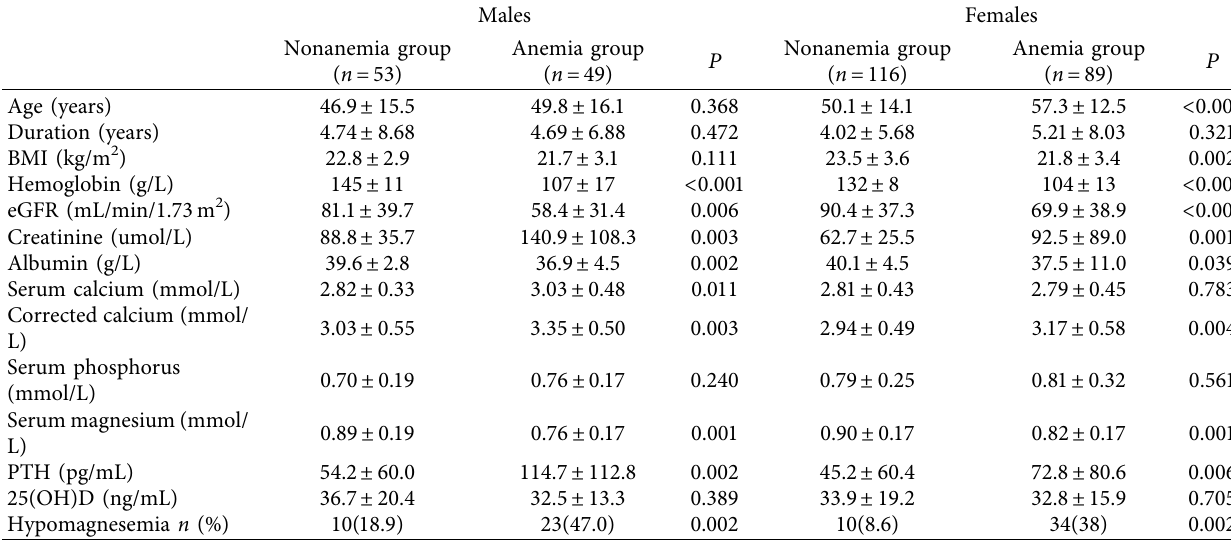
Table 2: Comparison of the parameters between the nonanemia group and the anemia group by